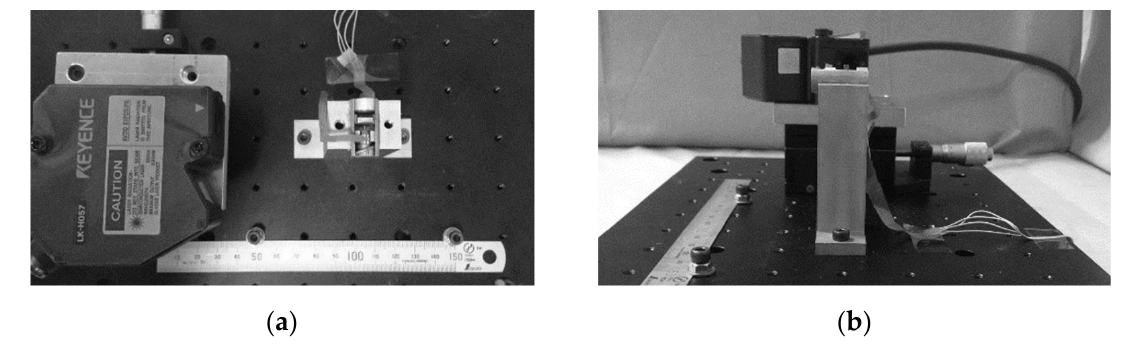
Figure 3. An experimental setup to measure the device’s motion accuracy: ( a ) top view and ( b ) side view.